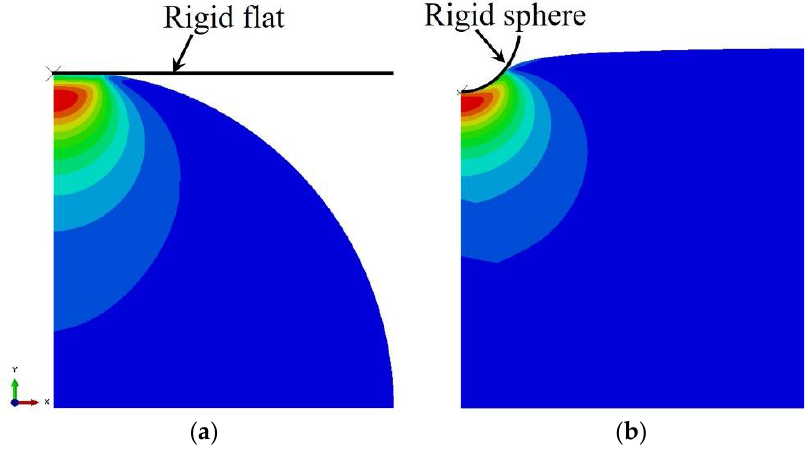
Figure 3. Finite element simulations of ( a ) a deformable asperity (flattening model) and ( b ) a rigid indenter (indentation model).